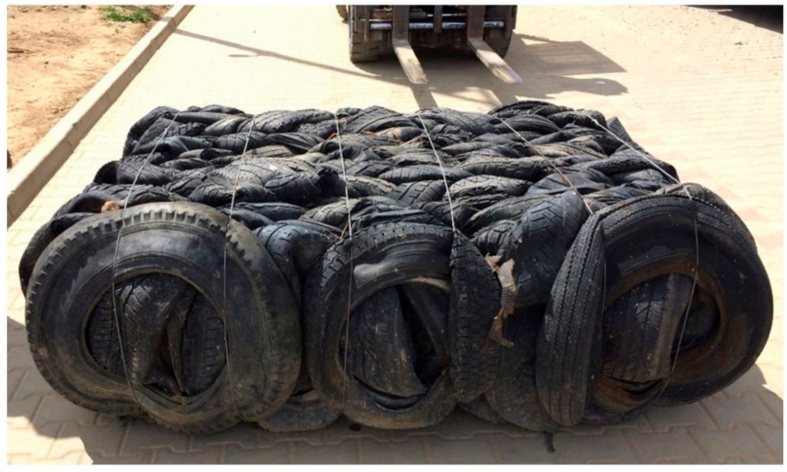
Figure 1. Typical tyre bale used in the current